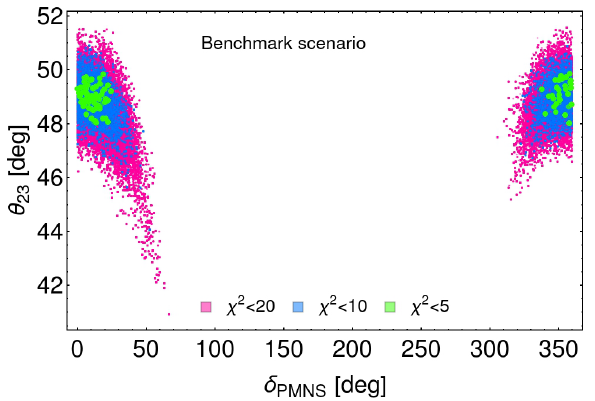
Figure 8 . Correlation between the Dirac CP phase and θ 23 in the neutrino sector in the benchmark scenario resulting from MCMC